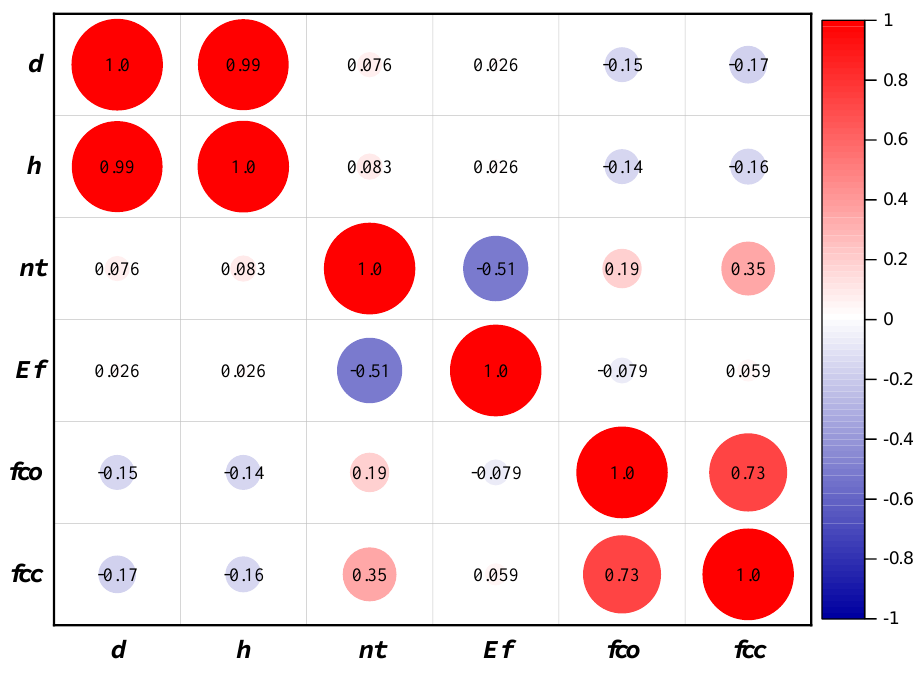
Figure 3. Correlation plot based on explanatory variables.